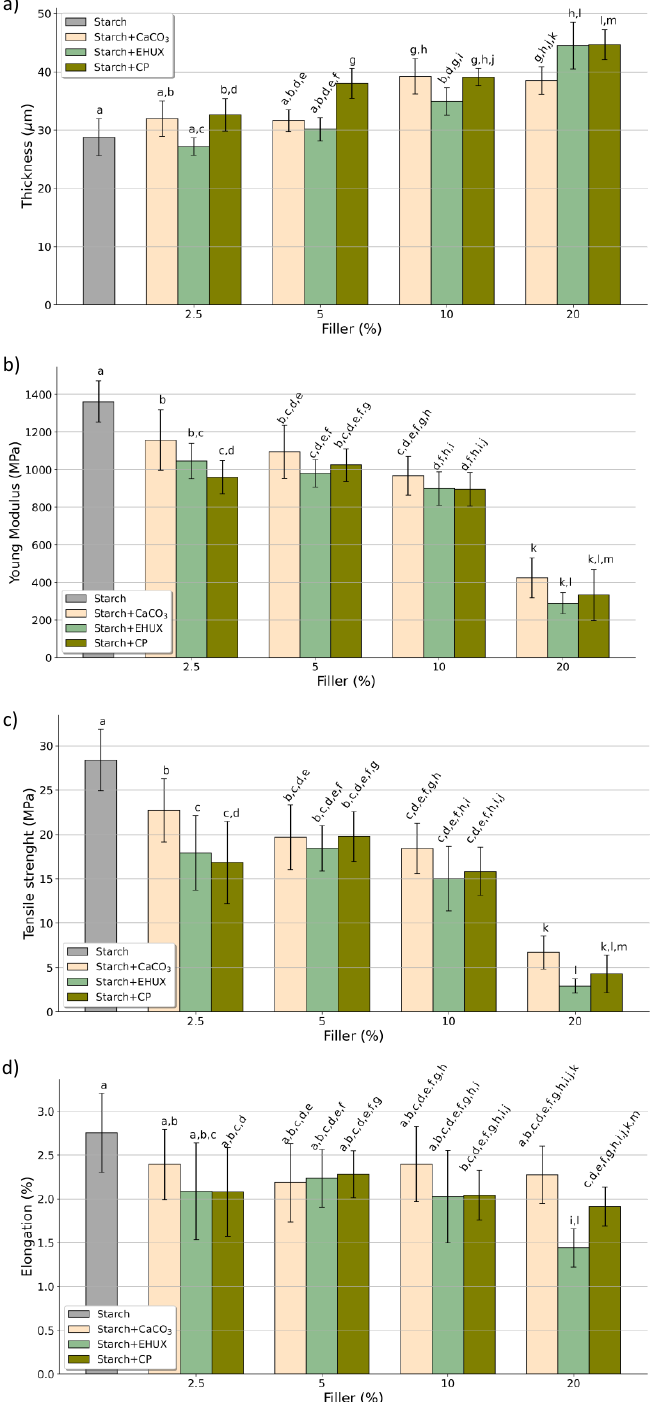
Figure 3. Thickness ( a ) and mechanical properties: ( b ) Young’s modulus, ( c ) tensile strength, and ( d ) elongation at break of starch films (control) and starch-based films containing commercial CaCO 3 , E. huxleyi (EHUX) or C. pseudoroscoffensis (CP) at different percentages (2.5, 5, 10, and 20% w / w ). Different letters between each condition indicate significant differences (Student’s t -test; p < 0.05).